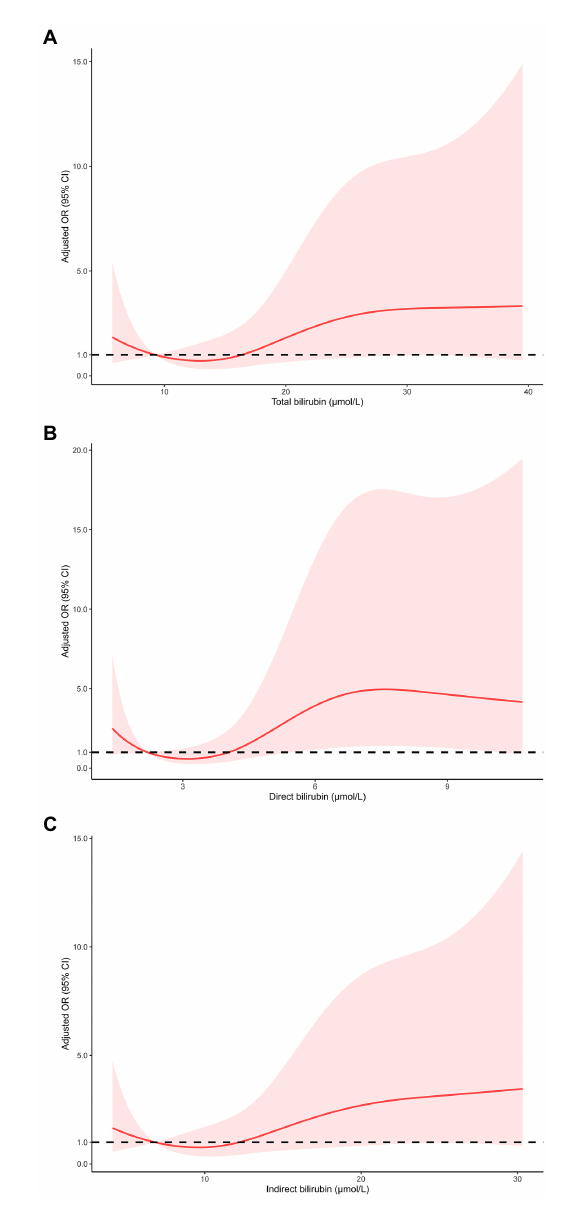
FIGURE 2 Restricted cubic spline regression models of the relationship between serum bilirubin levels and the risk of HT. Total bilirubin ( A ), direct bilirubin ( B ) and indirect bilirubin ( C ). The model was adjusted for the same confounding variables as in multivariable logistic regression model. HT, hemorrhagic transformation.